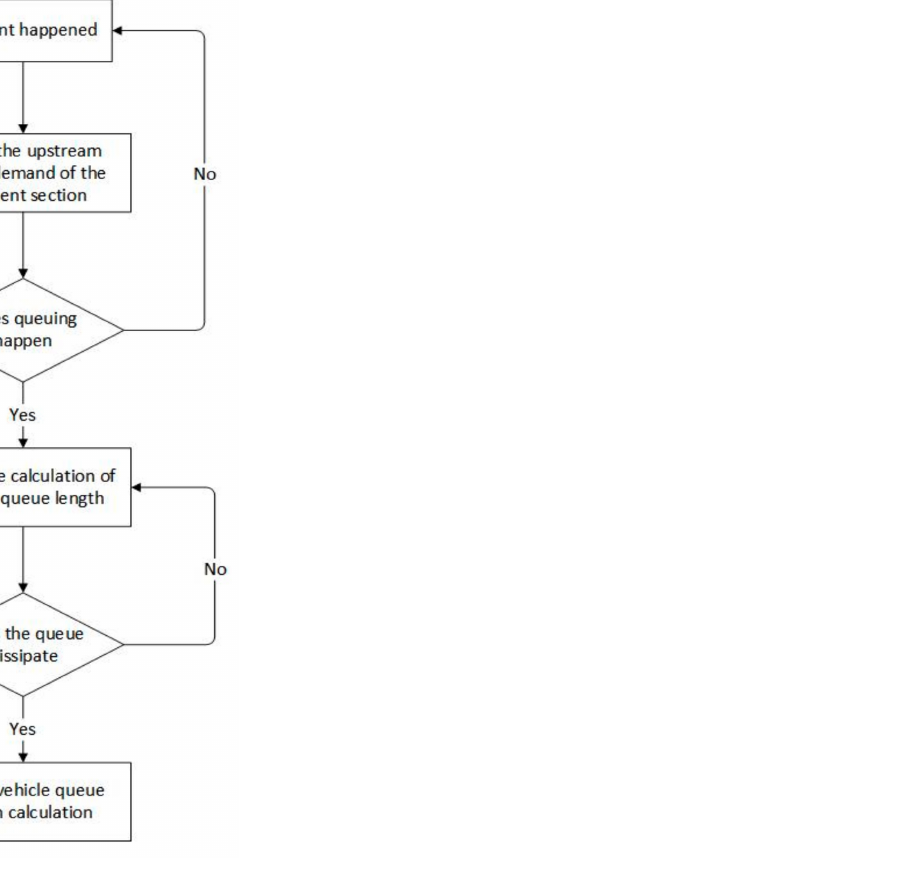
Figure 13. Flow chart for implementation of queue length estimation following an accident in the extra-long